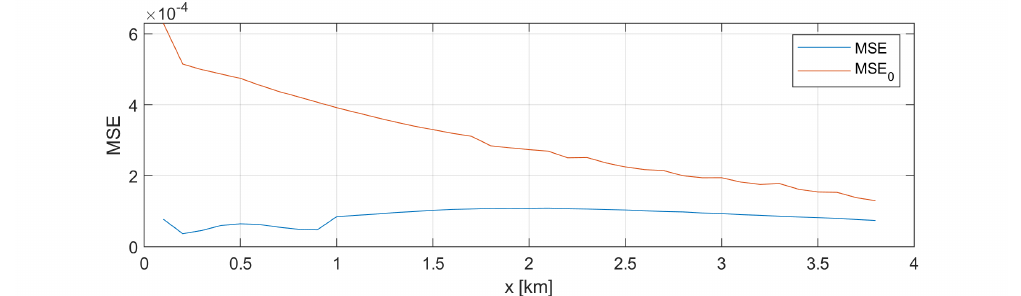
Figure 11. Mean-Squared Error ( MSE ) and the mean-squared error of Sandia National Laboratories-Simulating WAves Nearshore (SNL-SWAN) against the no-WEC condition ( MSE 0 ) for T p = 6 s and the conditions given in Figure